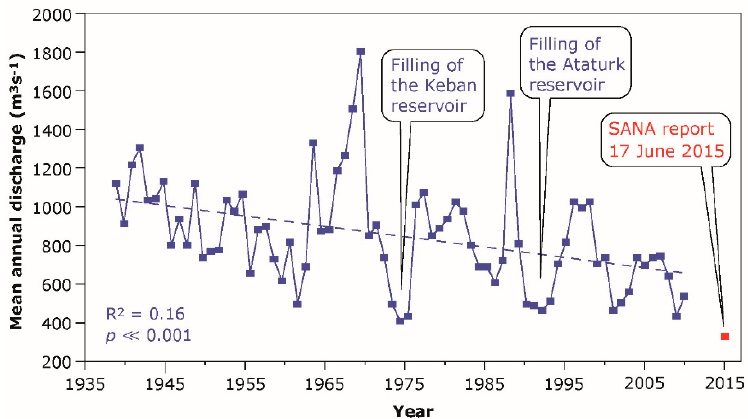
Figure 2. Mean annual discharge of the Euphrates River as monitored at the Jarablus hydrometric station, revealing a statistically significant negative trend until 2010 (based on data from [9]). The extremely low value for 2015 was reported in [13].